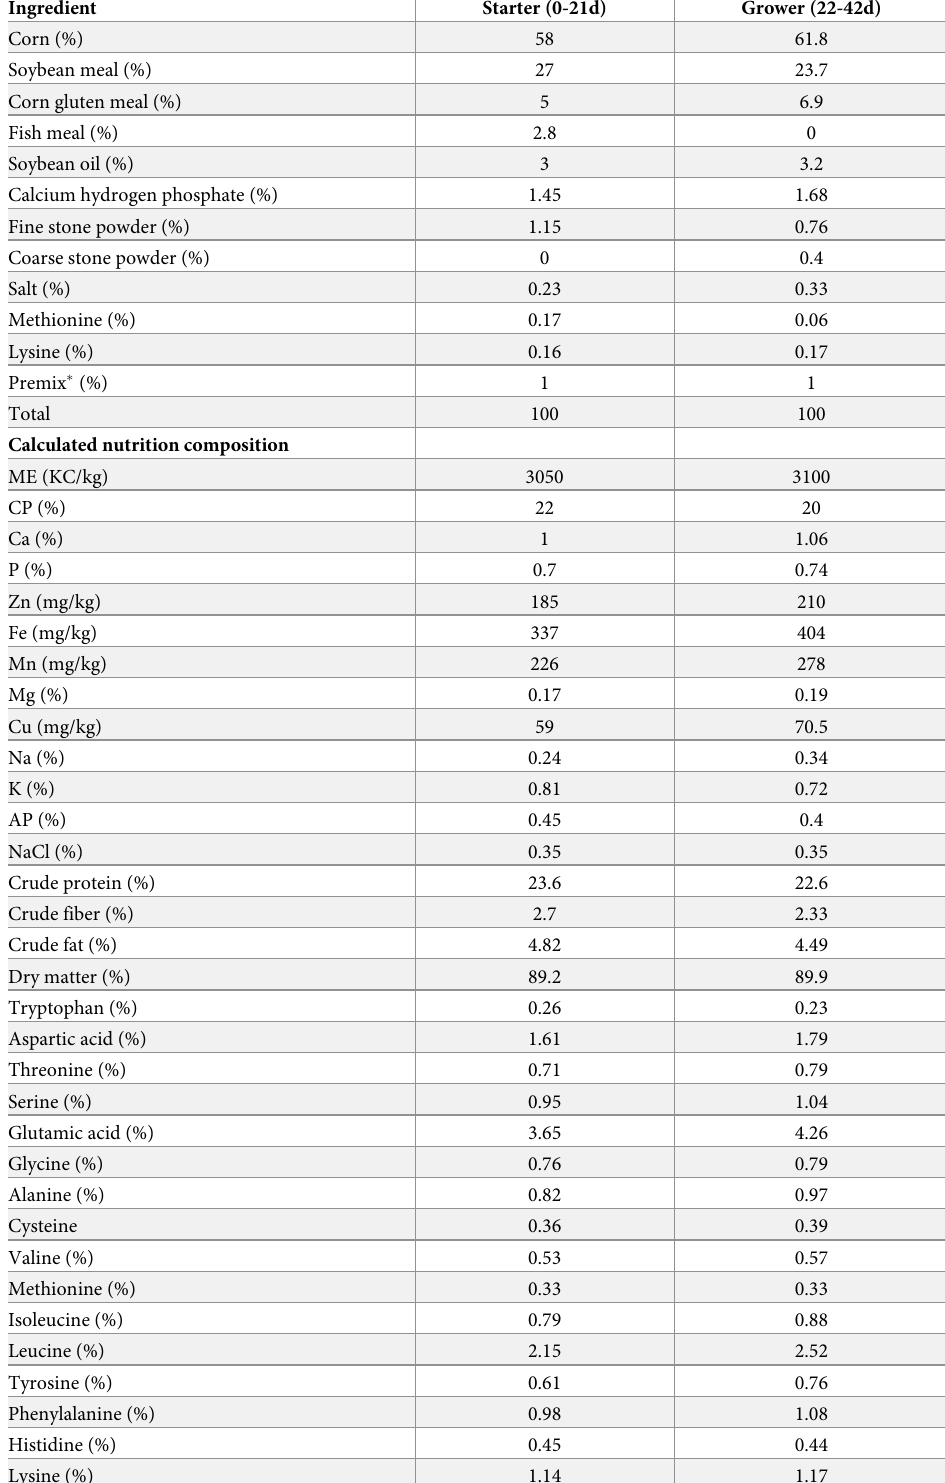
Table 1. Composition of the experimental diet